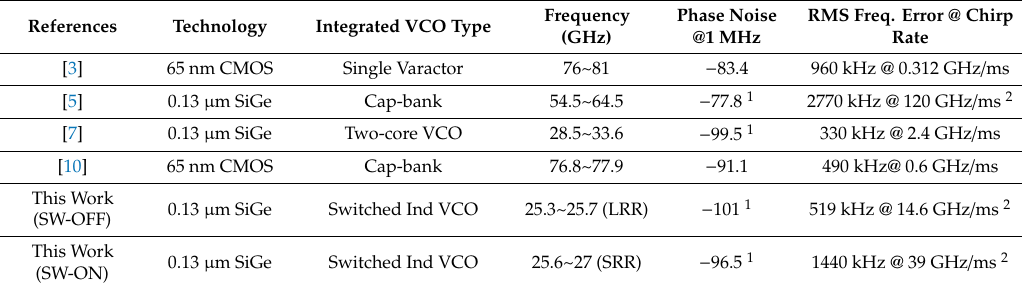
Figure 8. Measured fundamental frequency waveform of a multi-slope chirp sequence. Table 1. Comparison of state-of-the-art FMCW sources for radar